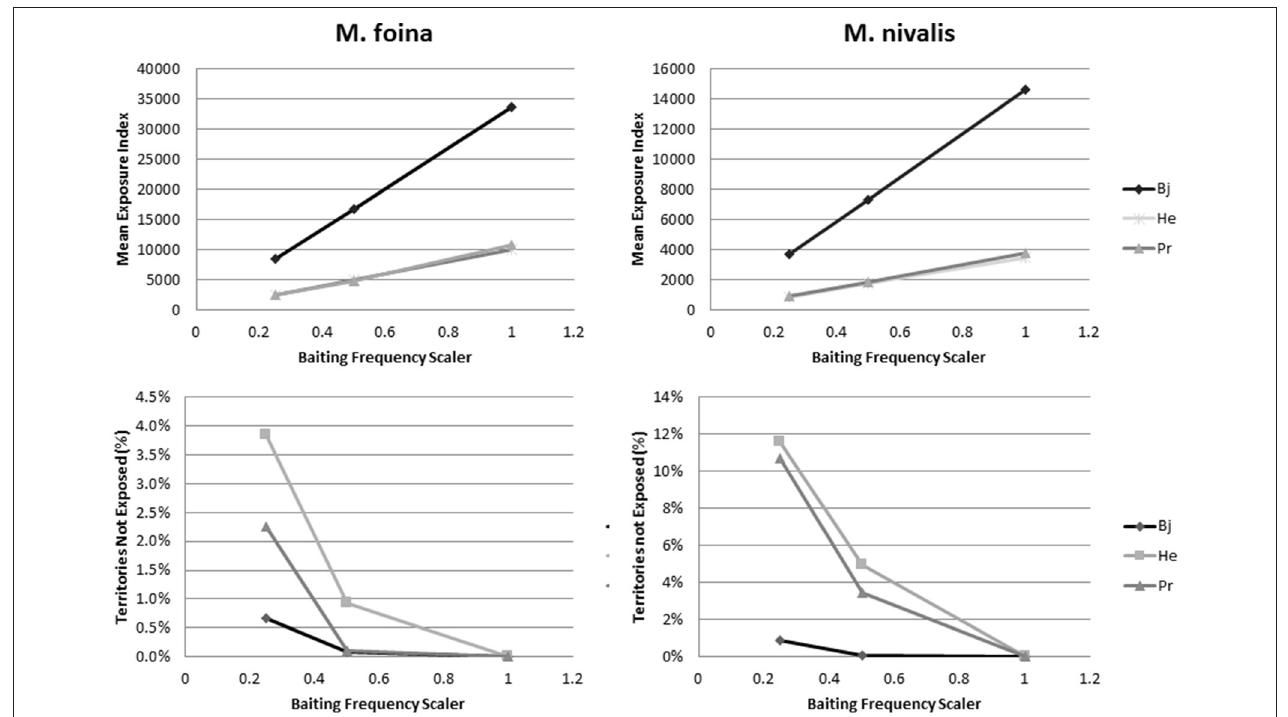
FIGURE 4 | Changes in mean exposure index and the percentage of territories not exposed when reducing the frequency of baiting to 50 and 75%. Bj, Bjerringbro; He, Herning; Pr, Præstø landscapes respectively. Each point is a based on multiple replicates, but with very small standard errors (not